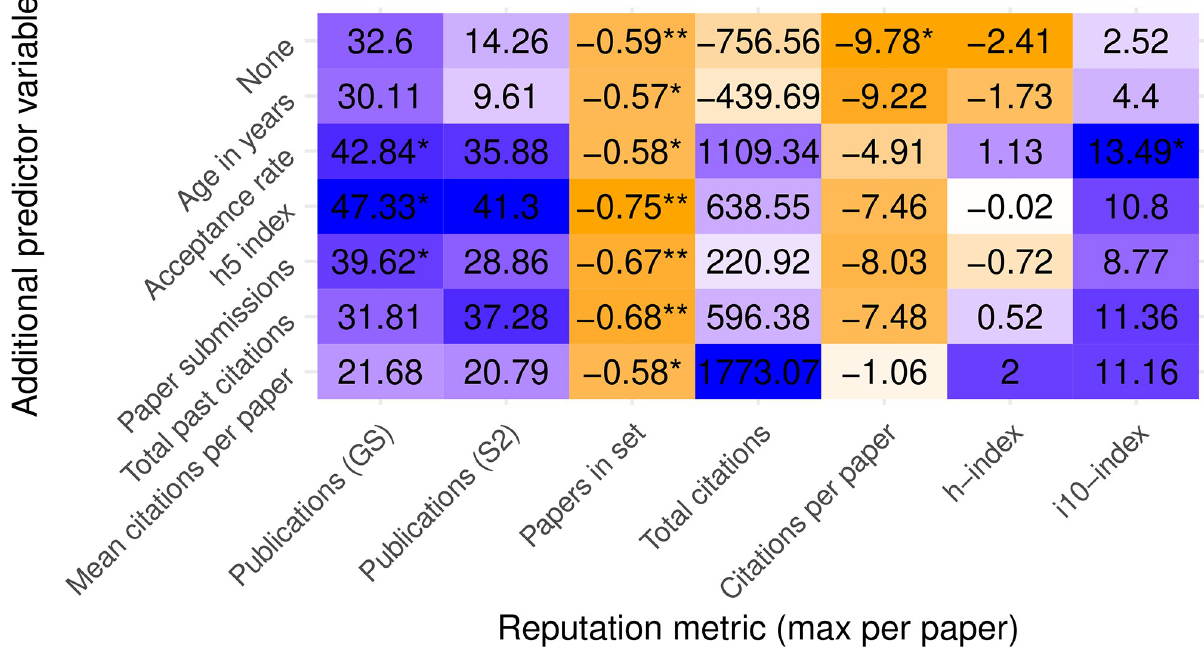
Fig 9. Mixed-effects linear regression models of various author prestige metrics as predicted by review policy and other conference variables with conference as a random effect. Values shown are the coefficient of the reviewing policy variable in the linear model and their associated p-values, estimated via Satterthwaite’s degrees of freedom method [30]. Positive coefficients (purple) indicate higher reputation in SB conferences. Negative coefficients (orange) indicate higher reputation in DB conferences. Darker colors reflect larger-magnitude values, normalized by columns. Stars indicate p values below 0.05, 0.01, and 0.001,